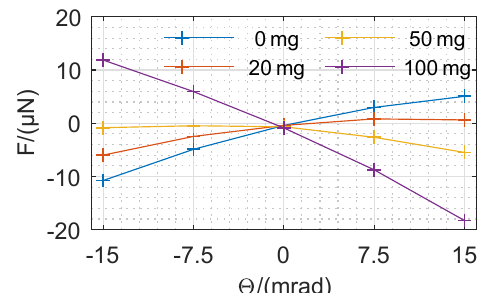
Figure 18. Influence of the trim weight at the lever ( m T 3 ) on the tilt sensitivity of the weighing